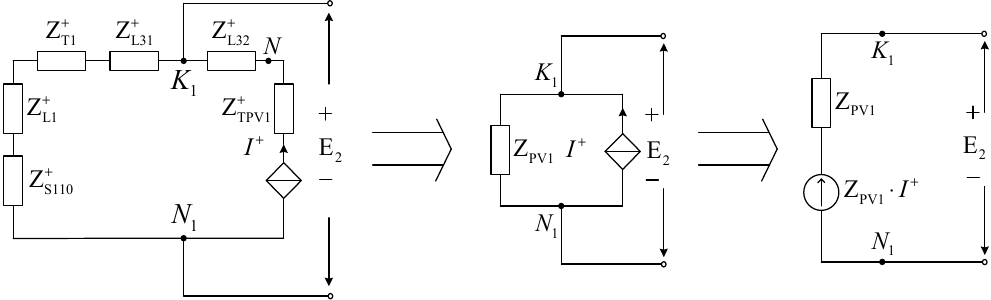
Figure 14. Equivalent network of PV1 current source.